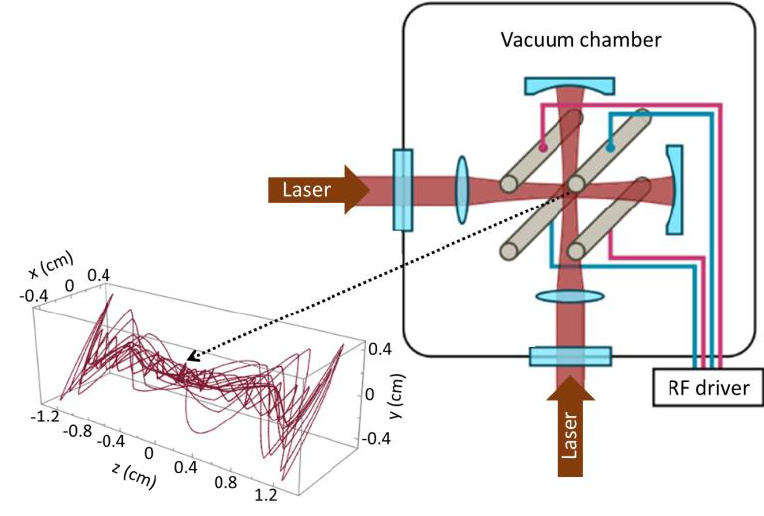
Figure 14. Hybrid trapping and deep laser cooling of a Yb 3+ :CsF 2 nanocrystal with the path function of its optical cooling.